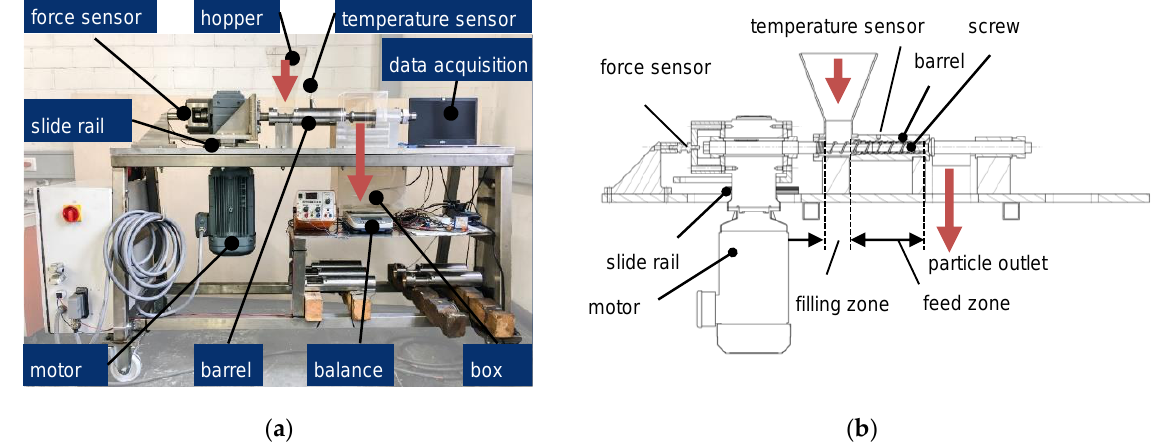
Figure 9. ( a ) Experimental setup; ( b ) sectional view of the test stand.